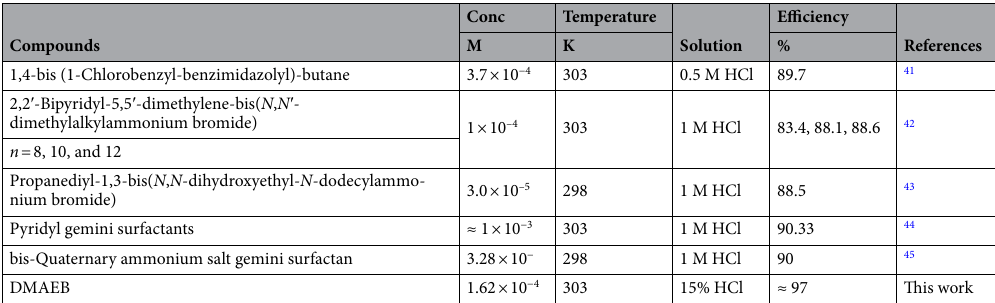
Conc Temperature